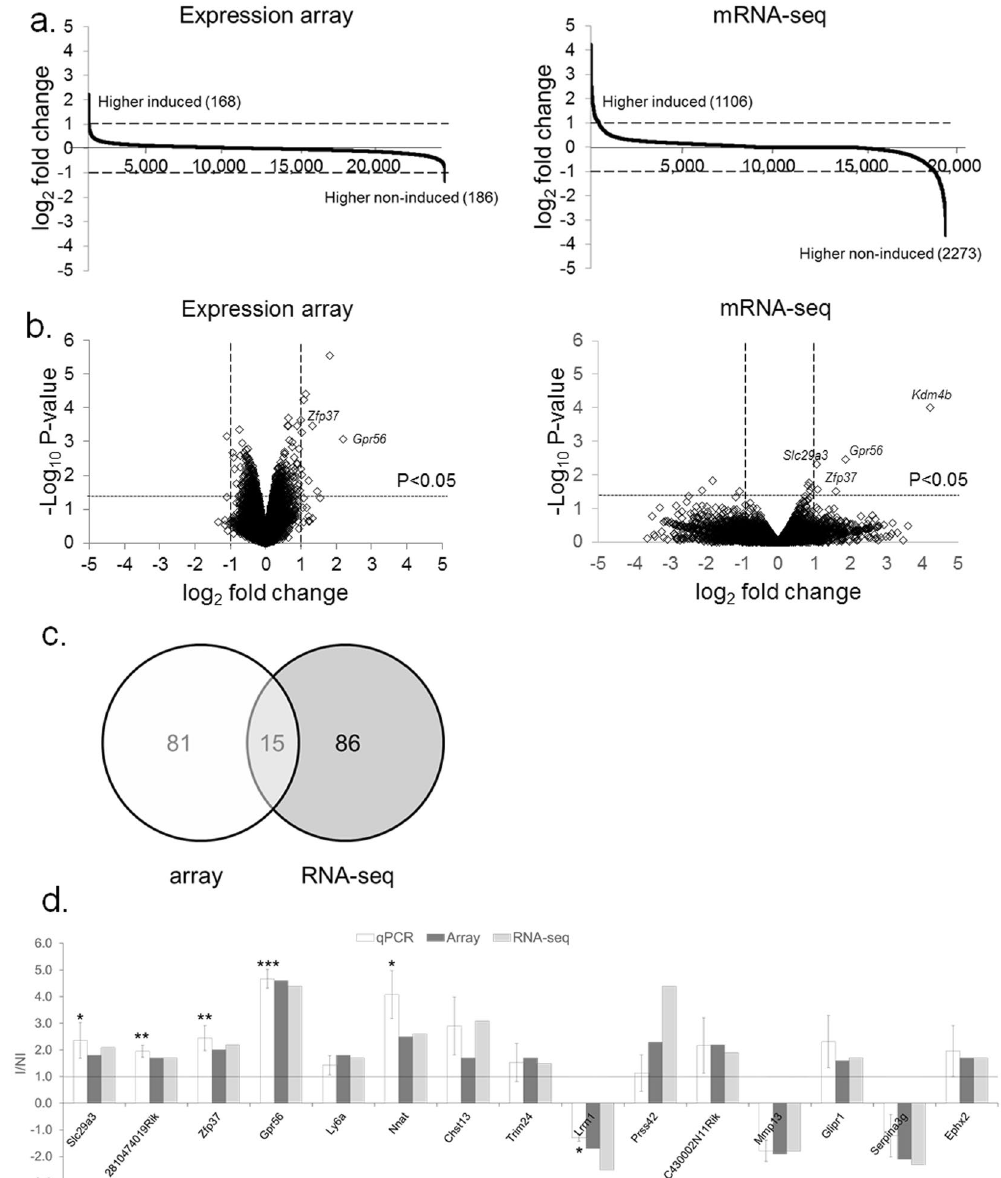
Figure 3. Transcriptome profiling of Kdm4b MEFs. ( a ) Fold change (log2 values) in transcript level of all genes under non-induced (NI) vs induced (I) conditions as measured by expression array and mRNA-seq. Gene expression levels of three MEF lines were averaged, after which ratios were calculated. A two-fold change is indicated by the stippled horizontal line. ( b ) Volcano plots of gene expression changes. Fold-changes were normalized on the NI control. A two-fold change is indicated by the stippled vertical lines. A dotted horizontal line indicates P = 0.05 from two-tailed t-test. ( c ) Number of genes that are significantly deregulated (1.5-fold, P < 0.05) in the same direction in microarray vs mRNA-seq. ( d ) qPCR validation of candidate genes. Shown are the ratios of I over NI relative expression levels, normalized on the geomean of three housekeeping genes. Dotted horizontal line indicates NI level. Error bars: standard error of ratios determined from 3–6 biological repeats per gene. Bars with an asterisk differ between NI vs I at * P < 0.05; ** P < 0.005; *** p < 0.001 as determined by two–tailed t-test on mean expression